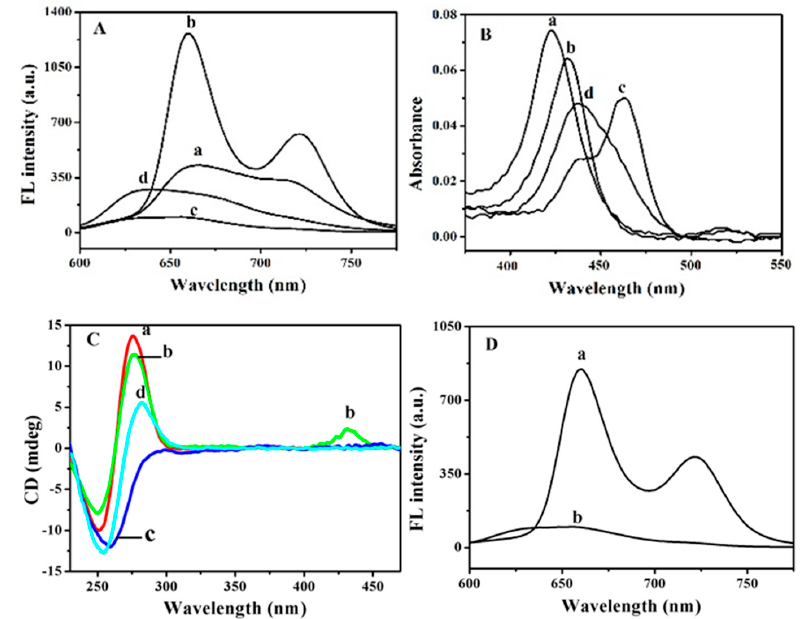
Figure 4. ( A ) Fluorescence and ( B ) UV-vis absorption spectra of (a) 1.0 μ M TMPyP, (b) 1.0 μ